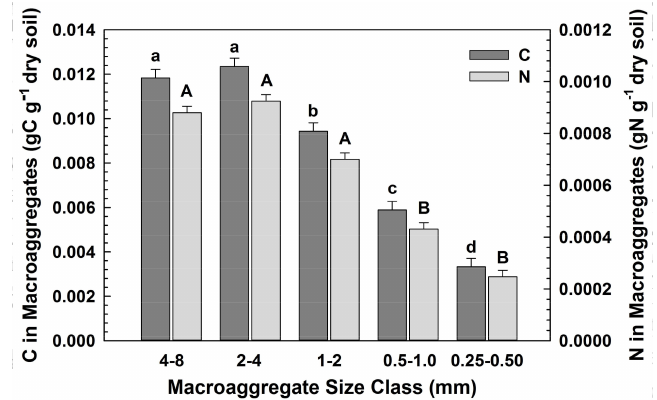
Figure 3. Fractions of C and N contained in macroaggregate size classes. Significant differences among size classes for C (left) are denoted by small letters, for N (right) by capital